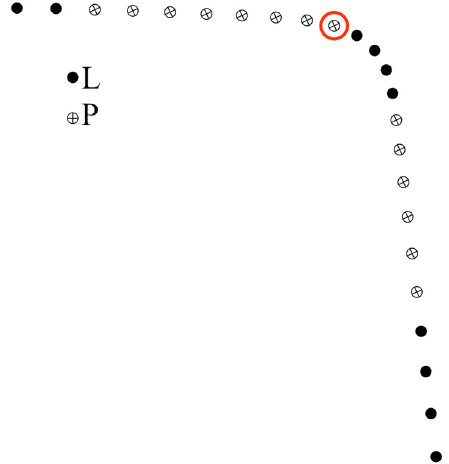
Figure 4. A point investigated for reclassification.